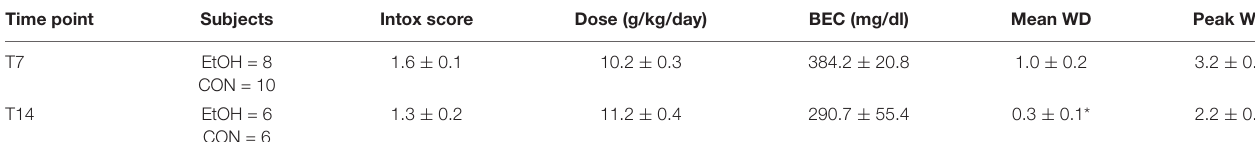
TABLE 2 | Animal model data.